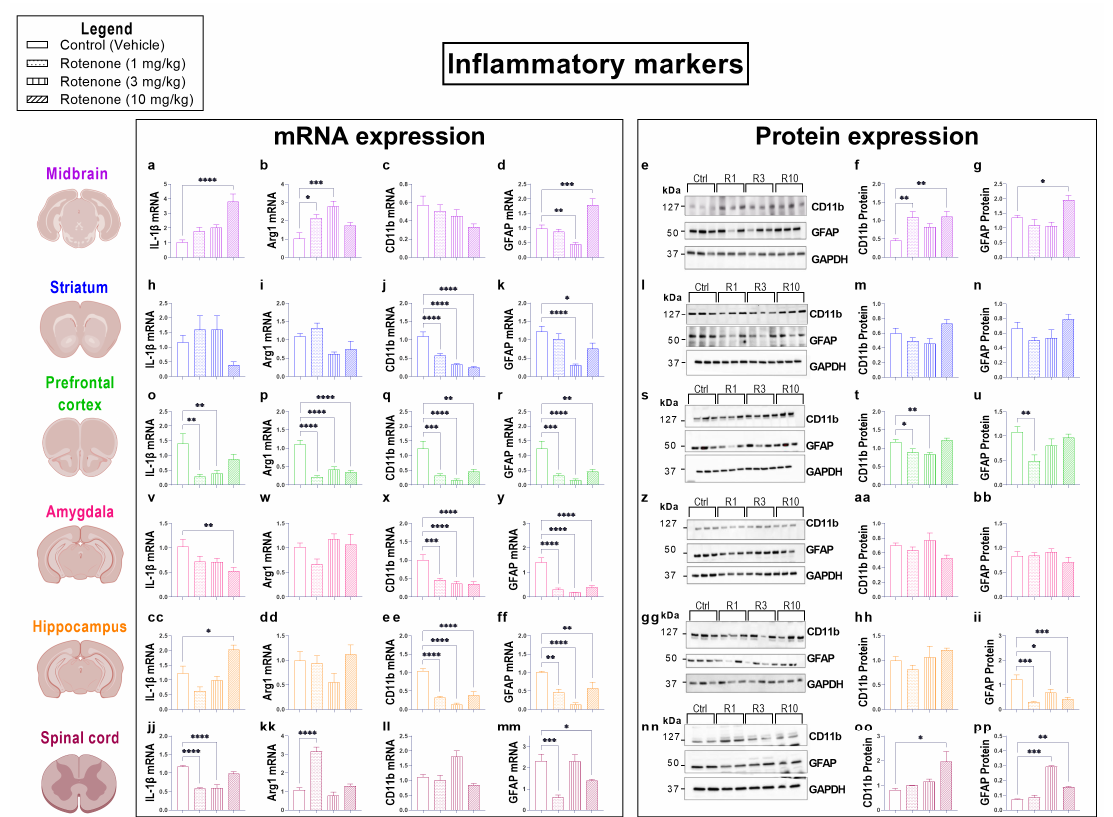
Figure 5. Rotenone-induced neuroinflammation is restricted to the midbrain and inhibited in extra- nigral CNS regions. Real-time qPCR analyses of IL-1 β , Arg1, CD11b, GFAP mRNA expression in the midbrain ( a – d ), striatum ( h – k ), prefrontal cortex ( o – r ), amygdala ( v – y ), hippocampus ( cc – ff ) and spinal cord ( jj – mm ) of mice treated with either 1, 3 and 10 mg/kg rotenone i.p. for 21 days. Fold changes were calculated using the ∆∆ Ct method after normalization to s18 ribosomal protein subunit gene. Data represents means of n = 4 samples for each group. Western blot and densitometric analysis of CD11b and GFAP protein expression in the midbrain ( e – g ), striatum ( l – n ), prefrontal cortex ( s – u ), amygdala ( z – bb ), hippocampus ( gg – ii ) and spinal cord ( nn – pp ). Densitometric results are expressed as mean ± S.E.M of 4–6 samples per group. * p < 0.05, ** p < 0.01, *** p < 0.001 or **** p < 0.0001 as determined by one-way ANOVA followed by Dunnett’s post hoc test. Ctrl: control; R1, 3, 10: Rotenone (1, 3, 10 mg/kg); GFAP: Glial Fibrillary Acidic Protein; IL-1 β : Interleukin-1-beta; Arg1: Arginase 1; GAPDH: Glyceraldehyde 3-phosphate Dehydrogenase; kDa: